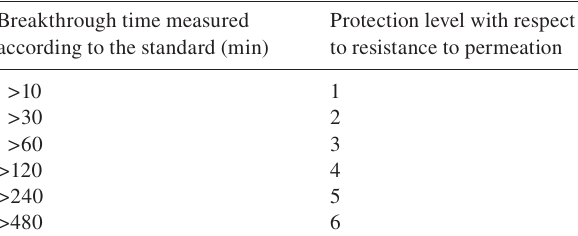
Table 1 Protection levels with respect to resistance to permeation according to PN-EN 374-3 Standard 2005. Breakthrough time measured Protection level with